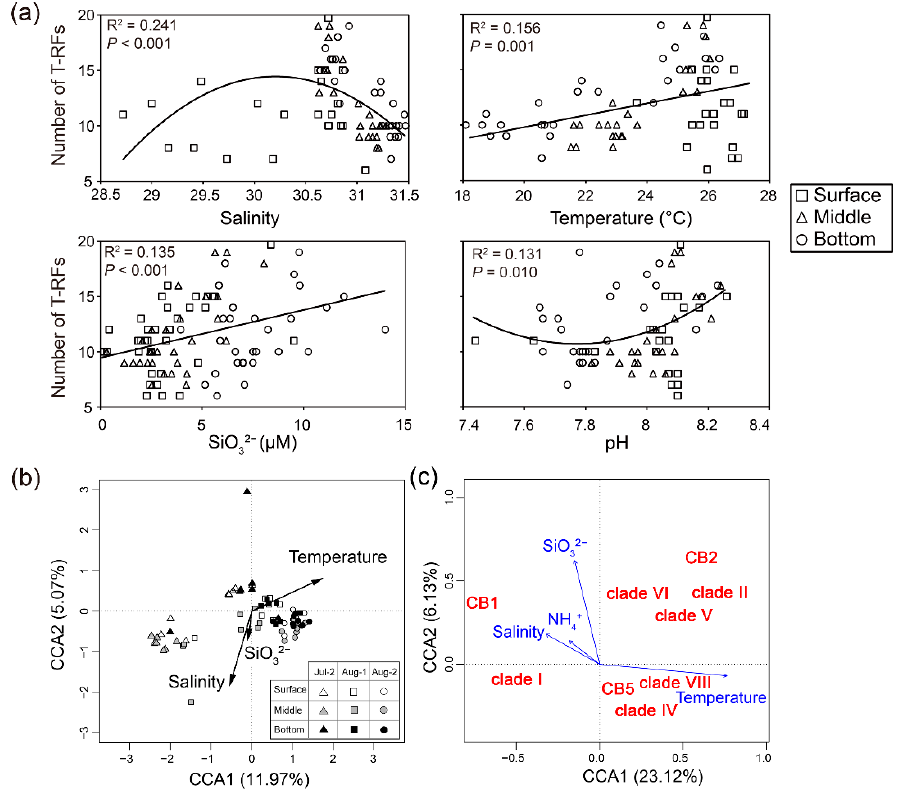
Figure 7. The regression relationships between T-RF richness and four mostly important environmental factors ( a ). The canonical correspondence analysis (CCA) plots in which the genotype assemblages were based on the relative abundance of each T-RF ( b ), and of major genotype clades ( c ) recovered during the cruises Jul-2, Aug-1, and Aug-2. The symbols in different colors and shapes indicate water layers and sampling cruises, respectively.